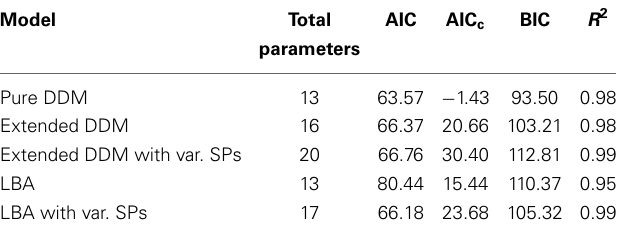
Table 1 | DDM and LBA model fit comparisons, with fit quality defined by the match to mean ER and RT